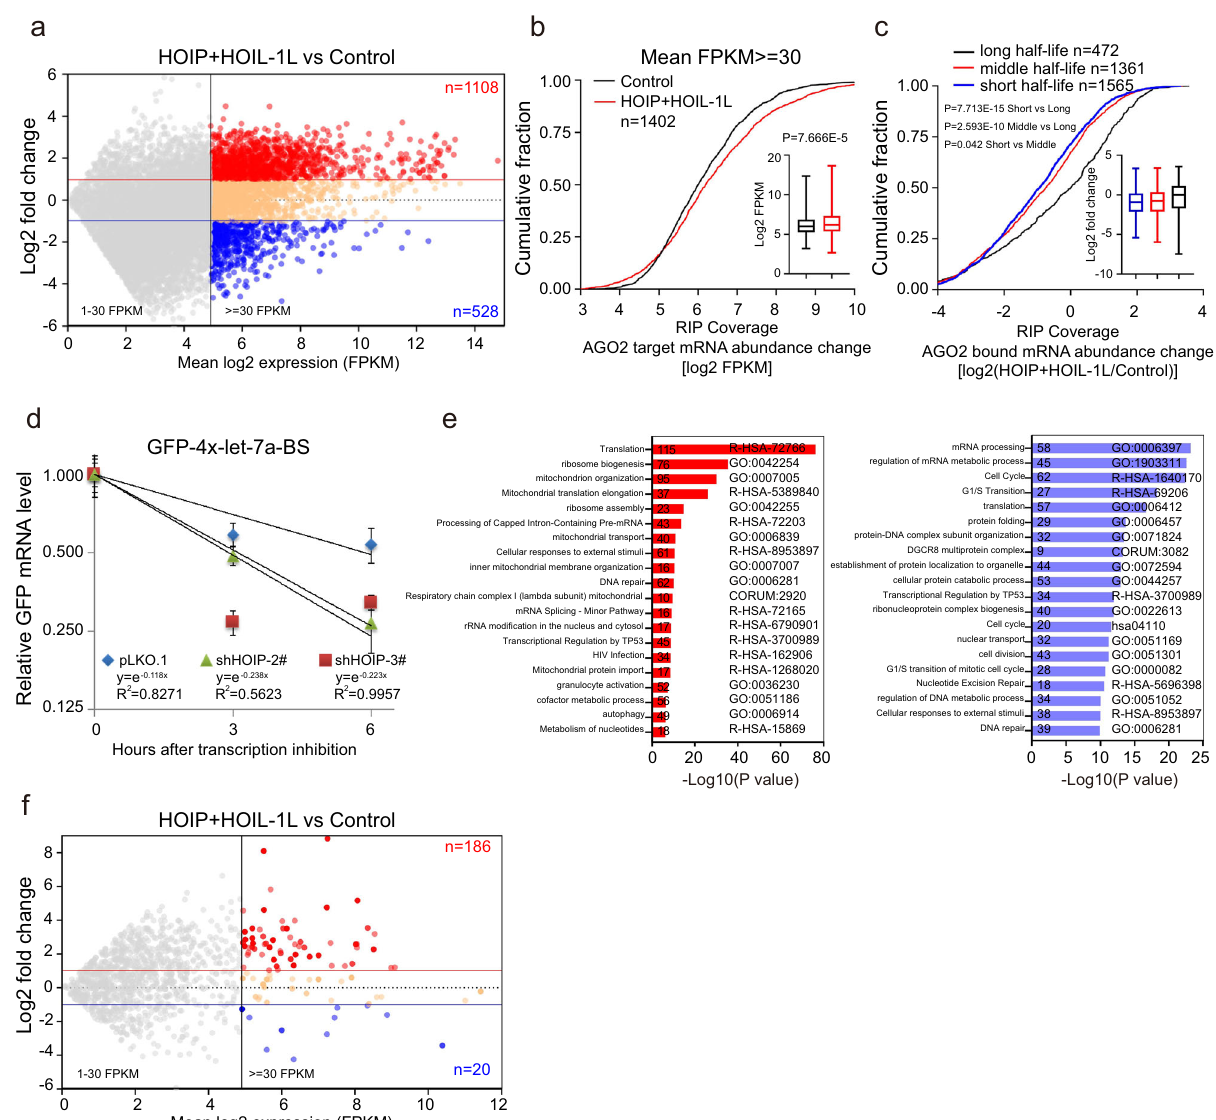
Fig. 7 M1-Ubi of AGO2 globally promotes mRNA accumulation. a – c M1-Ubi of AGO2 promoted mRNA accumulation. Scatter plot of mRNA expression pro fi les in RNA-Seq ( a ); and cumulative fraction analyses for the abundance of AGO2 bound mRNA transcripts (which were covered by RIP-Seq) in RNA- Seq ( b , n = 1402 mRNAs), which further were categorized as short-, middle- and long-half-life ( c ), in stable HeLa-Flag-AGO2 cells expressing HOIP and HOIL-1L. In box plots, the lines represent the median, fi rst and third quartiles, the whiskers denote the minima and maxima; P -values were calculated using a two-sided Mann – Whitney U test for cumulative fraction analysis ( b , c ). d Knockdown of HOIP accelerated the degradation of let-7a-targeted GFP-4xlet- 7a-BS. HeLa cells stably knocking down of HOIP by shRNAs were transfected with GFP-4xlet-7a-BS for 24 h, and then cells were treated with 5 μ g/ml Actinomycin D for indicated times. GFP mRNA levels were measured by qRT-PCR and normalized with β -actin mRNA. Data were mean ± s.d., n = 3 biologically independent samples, and P -values were determined by unpaired two-sided t-test. e Enriched Gene Ontology (GO) categories for genes with 2-fold up-regulated (red, left panel) and down-regulated (blue, right panel) mRNA transcripts when HOIP and HOIL-1L were overexpressed. P values for enrichment of the indicated GO category were computed by Metascape. f Ectopically expressed LUBAC increased lncRNA transcripts accumulation. Scatter plots of lncRNA expression pro fi les by RNA-Seq in stable HeLa-Flag-AGO2 cells expressing HOIP and HOIL-1L or control tissues (Fig. 8d, left panel), but the expression levels of the non-